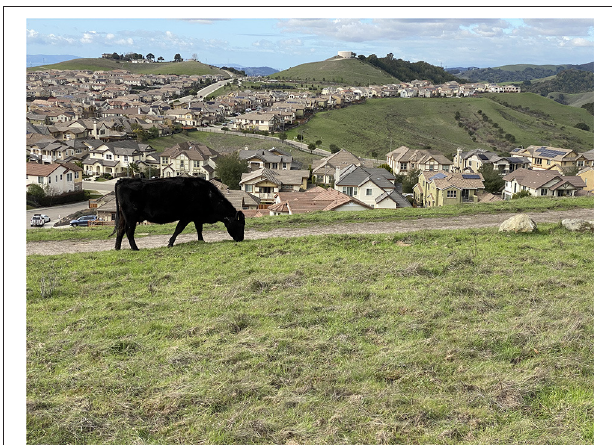
FIGURE 13 | Cattle grazing the Dublin Hills Regional Park, Alameda County, California remove significant fine fuel from the landscape. Once livestock are removed, as in many places in the world, land abandonment has allowed fuels to grow abundantly, leaving highly ignitable, standing dry grass through the summer and fire season. Photo: S.